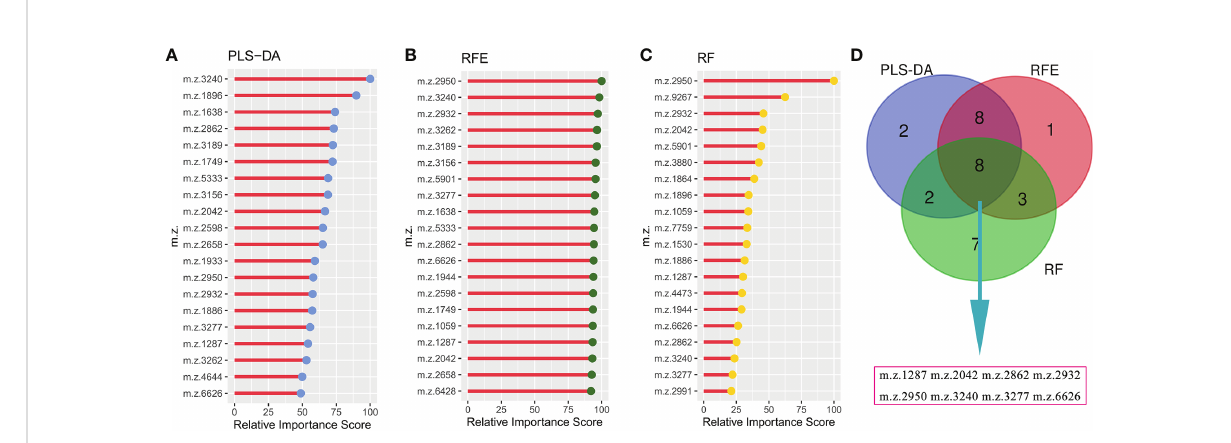
FIGURE 4 Selecting signature peptide peaks using machine learning algorithms (A) , top 20 features prioritized by PLS-DA ranked by the decrease in feature importance scores; (B) , top 20 features prioritized by RFE ranked by the decrease in feature importance scores; (C) , top 20 features prioritized by RF ranked by the decrease in feature importance scores; (D) , fi nal 8 serum peptide features were achieved by taking the intersection of the top 20 features fi ltered by the three machine learning algorithms.